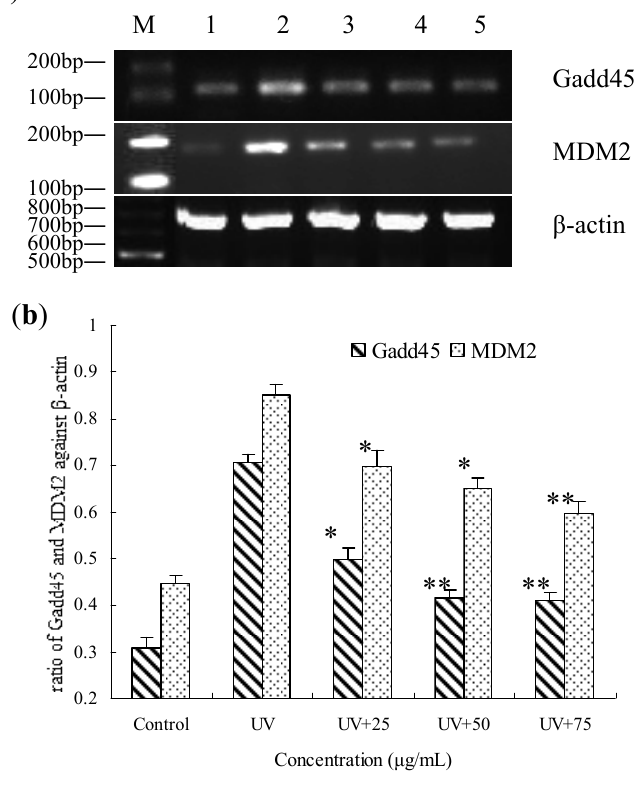
Figure 7. Gene expression of Gadd45 and MDM2 by RT-PCR in UV-irradiated HepG2 cells that were pre-treated for 12 h with BA. ( a ) Lane M, marker; lane 1 control (no UV radiation); lane 5, UV+ 75 μ g/mL; ( b ) The relative expression of Gadd45 and MDM2 value